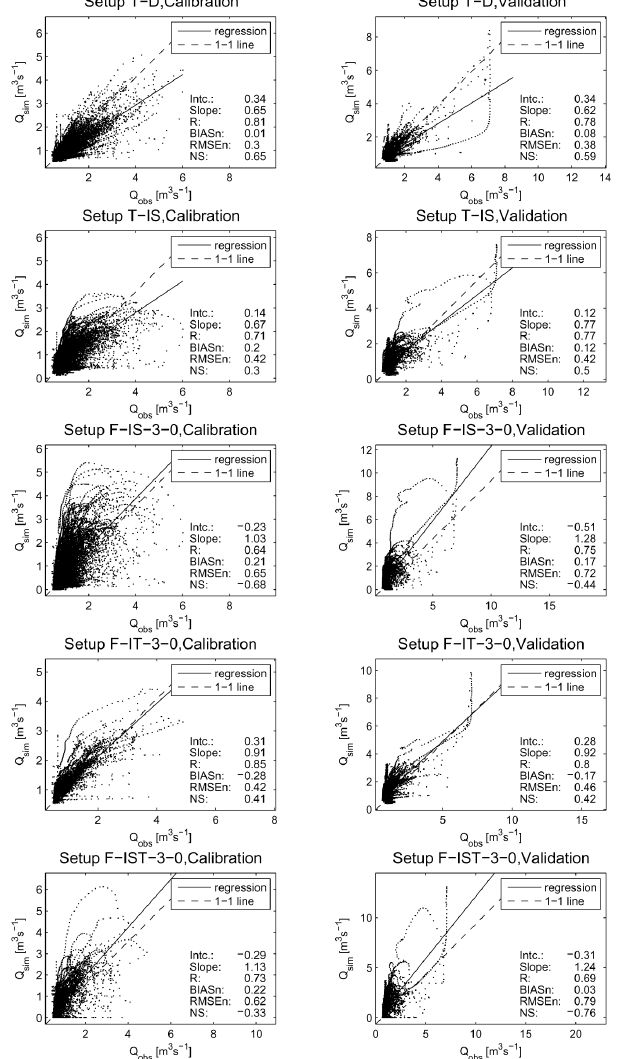
Fig. 10. Scatter plots of observed and simulated discharge in catch- ment Rummen–Melsterbeek for calibration set-ups T-D (1), T-IS (2), F-IS-3-0 (3), F-IT-3-0 (4) and F-IST-3-0 (5) in the calibration (left) and validation (right)